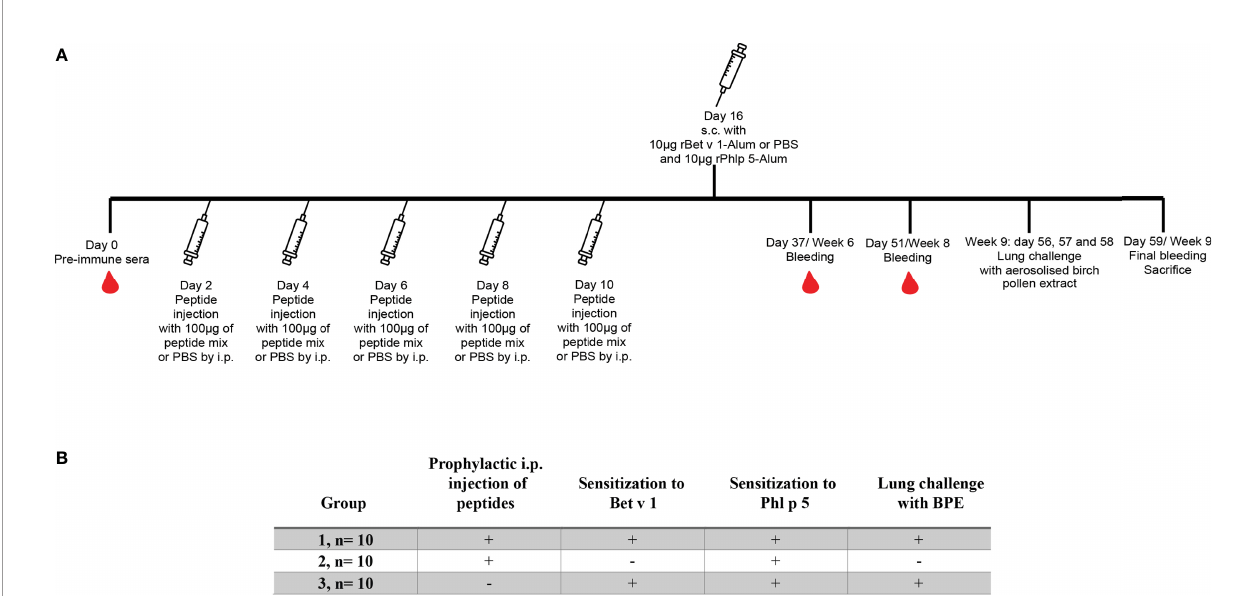
FIGURE 2 | Scheme for the second preventive treatment with more frequent administration of Bet v 1-derived peptides. (A) Three to four week old female BALB/c mice received 5 prophylactic i.p. injections of 100µg of a mix of Bet v 1-derived peptides or PBS followed by one s.c. sensitisation with 10µg of either rBet v 1 or PBS together with 10µg of an unrelated control allergen, rPhl p 5, adsorbed to Al(OH) 3 . Thereafter, mice were challenged with either aerosolised birch pollen extract or PBS to assess airway hyper responsiveness for three consecutive days (56, 57 and 58) and then sacri fi ced on day 59 to examine T cell responses. Time points of prophylactic injections, sensitisation, bleeding, a lung challenge and sacri fi ce are indicated. (B) Characteristics of the 3 mouse